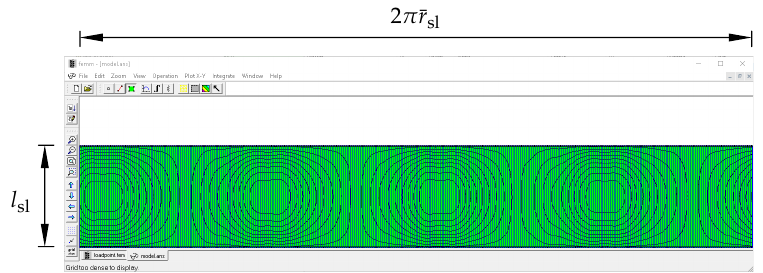
Figure 5. The unrolled sleeve during the calculation of P ec in FEMM. The sleeve is split up into small surface areas, each with the circumferential width of 2 π ¯ r sl / K and the axial length of l sl , as it can be seen in Figure 5. The sleeve can be axially positioned, and l sl and l Fe do not have to be equal. The eddy current excitation at p k ( i ec, k ) for the calculation of P ec in the new 2D magnetostatic problem in FEMM is obtained based on the corresponding magnitude of J ec ( J ec, k ) in the surface area ( A ) between two neighboring evaluation points according to (6) and (18)